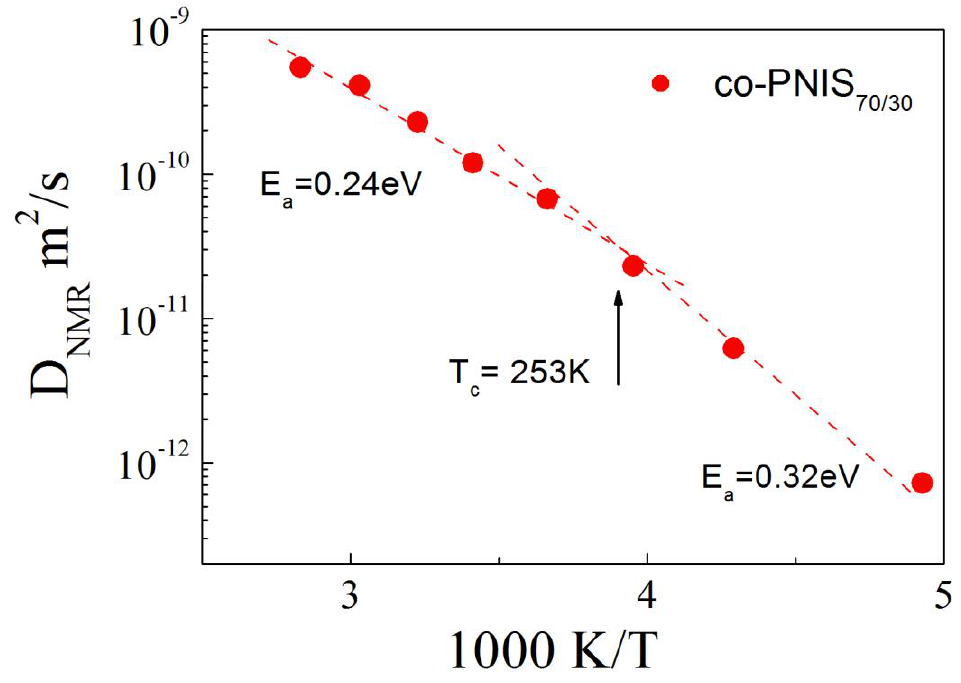
Figure 6. Temperature dependences of the water self-diffusion coefficient in the co-PNIS 70/30 membrane hydrated during five days at room temperature and 100% humidity.